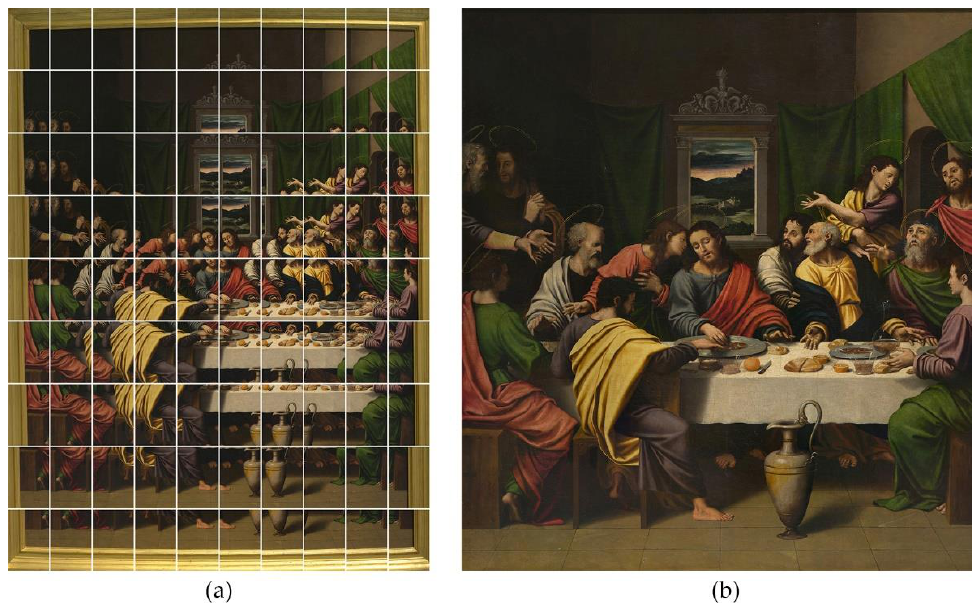
Figure 13. ( a ) Set of 90 pictures taken during the gigapixel capture. ( b ) Stitched gigapixel Image. A reference picture, with the X-Rite Colour Checker Chart, was taken to generate a specific colour profile for the lighting conditions of the scene, and to adjust the white balance in the RAW development process precisely. In this case, only the lights of the museum were used as the lighting